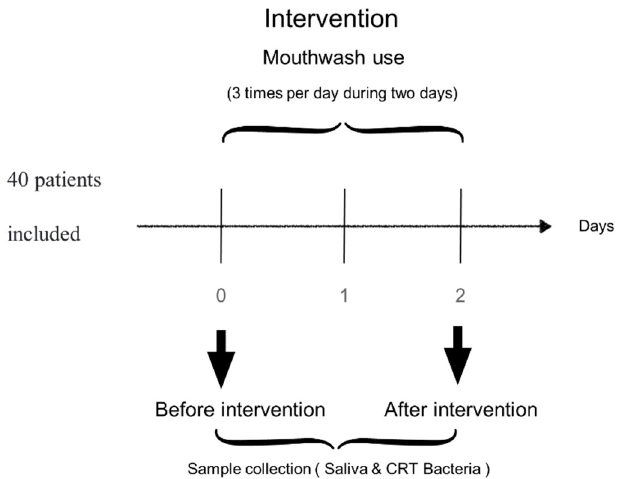
Figure 3. Study design. Visit protocol on mouthwash experience. The registered participants were 40 patients who had signed the informed consent and understood the procedure. They were randomly divided into four groups and were instructed to use mouthwash three times a day for two days. Sample of saliva and CRT bacteria were performed just before intervention, on the same day, and two days later.